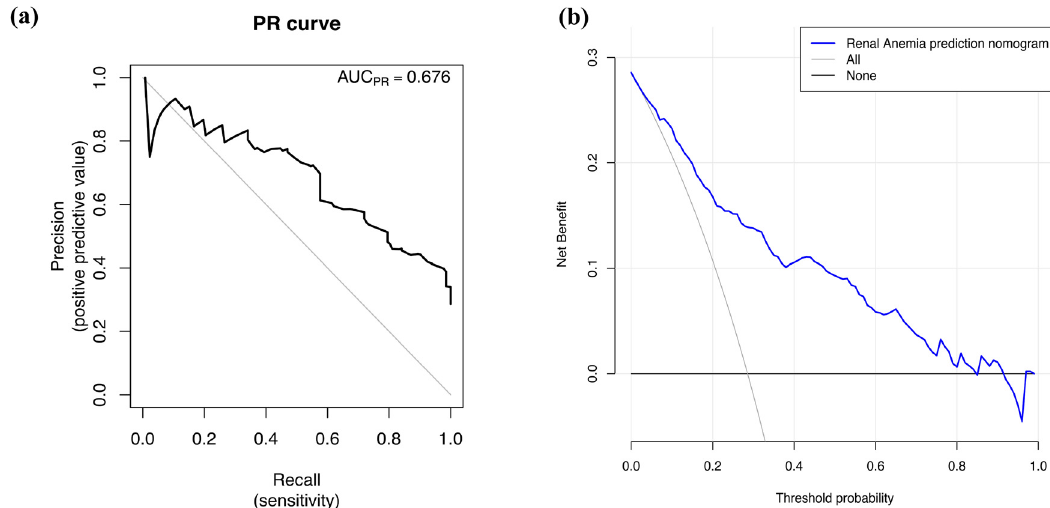
Figure 4: PR curve and decision curve analysis ( DCA ) for the renal anaemia nomogram. ( a ) PR curve. It showed that the AUC of this model for predicting renal anaemia was 0.676. ( b ) DCA. The y - axis measures the net bene fi t. The blue solid line represents the renal anaemia nomogram. The solid grey line represents the assumption that all patients with IgA nephropathy developed renal anaemia. The solid black line represents the assumption that none of the patients with IgA nephropathy developed renal anaemia. The decision analysis curve showed that the net bene fi t rate was > 0 at the high - risk threshold of 1 – 84%, which was clinically signi fi cant. Abbreviations: PR curve, precision - recall curve; AUC, area under the